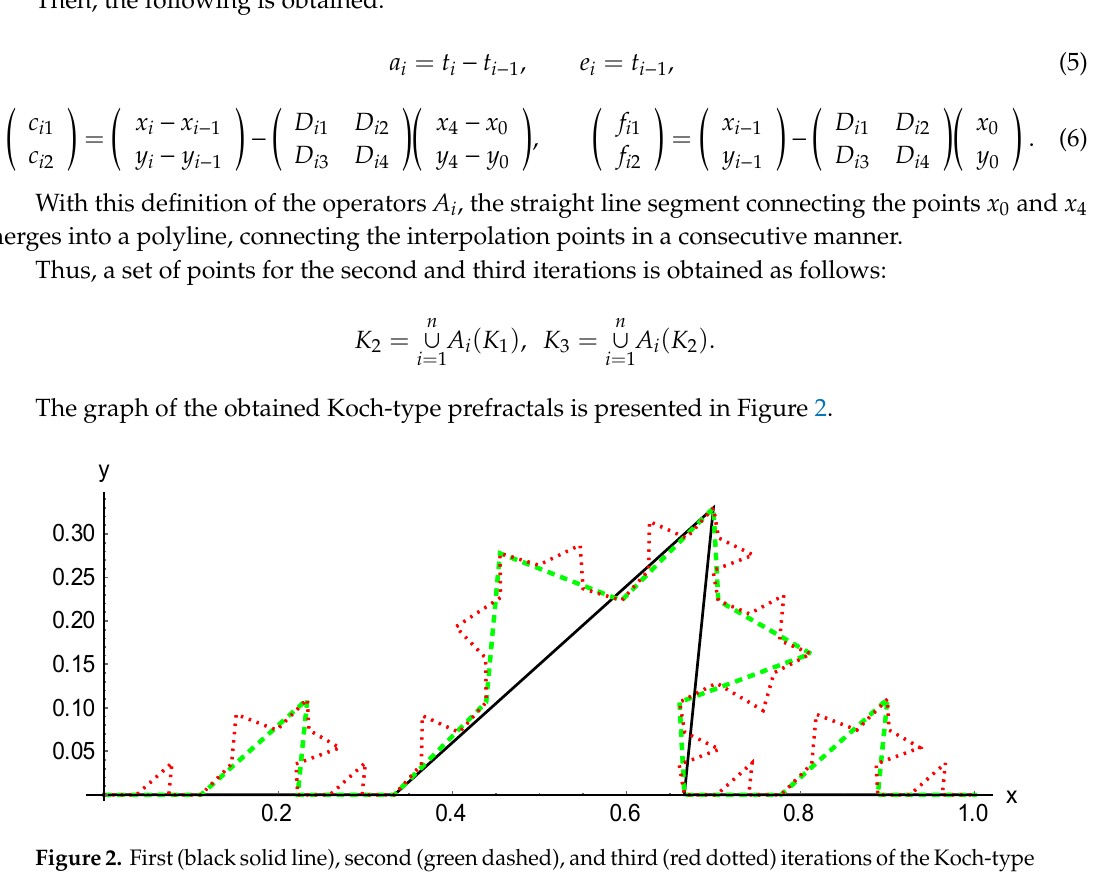
Figure 2. First (black solid line), second (green dashed), and third (red dotted) iterations of the Koch-type fractal. Coordinates of the central vertex: x 2 = 0.7, y 2 =